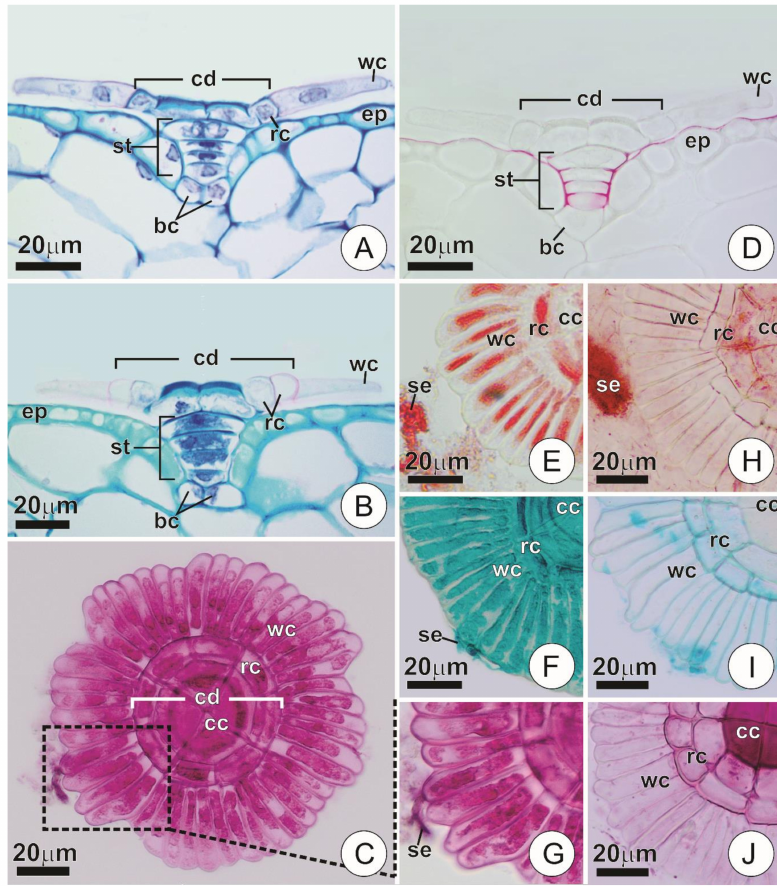
Figure 2. Anatomy and histochemistry of secretory trichomes. ( A , B ) Longitudinal section of a trichome showing the overall structure in young ( A ) and mature ( B ) bracts. Note the distinct appearance of the wing cells in each of the phases. ( C ) Shield of a secreting trichome. Note the overall structure and wing cells with conspicuous protoplasts marked for mucilage (in pink). ( D ) Longitudinal section of a trichome showing cuticle arrangement (in red). ( E – J ) Portions of the shield showing histochemical characterization of trichomes and secretion in young ( E – G ) and mature ( H – J ) bracts. ( E , H ) Xylidine pounceau, for proteins (in red). ( F , I ) Alcian blue, for mucilages (in blue). ( G , J ) Ruthenium red, for mucilages (in pink). (bc = basal cells; cc = central cells; cd = central disc; ep = ordinary epidermis cells; rc = ring cells; se = secretion; st = stalk; wc = wing